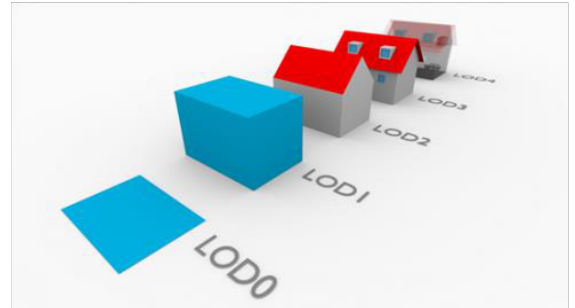
Figure 3. The LoD representations (Biljecki et al.,